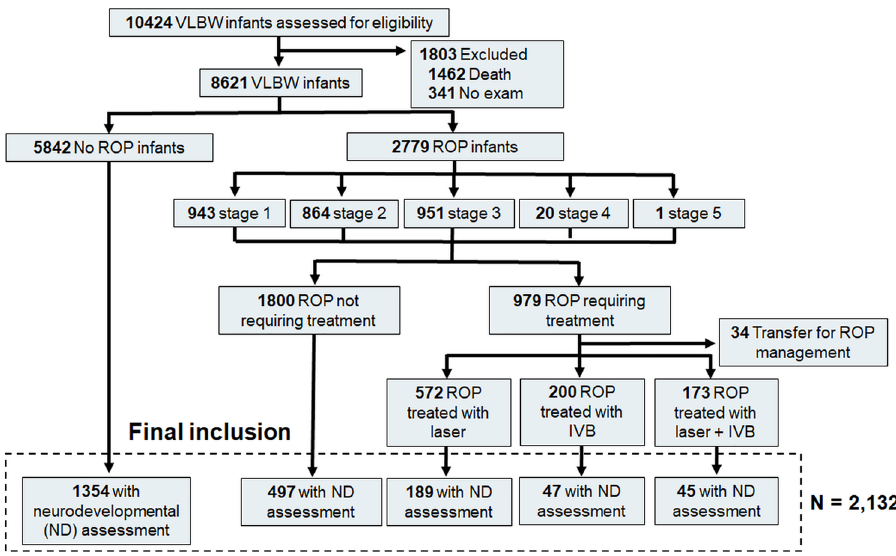
Figure 1. Flowchart illustrating the inclusion and exclusion criteria of the present study and the number of infants meeting the criteria. VLBW Very Low birthweight; ROP retinopathy of